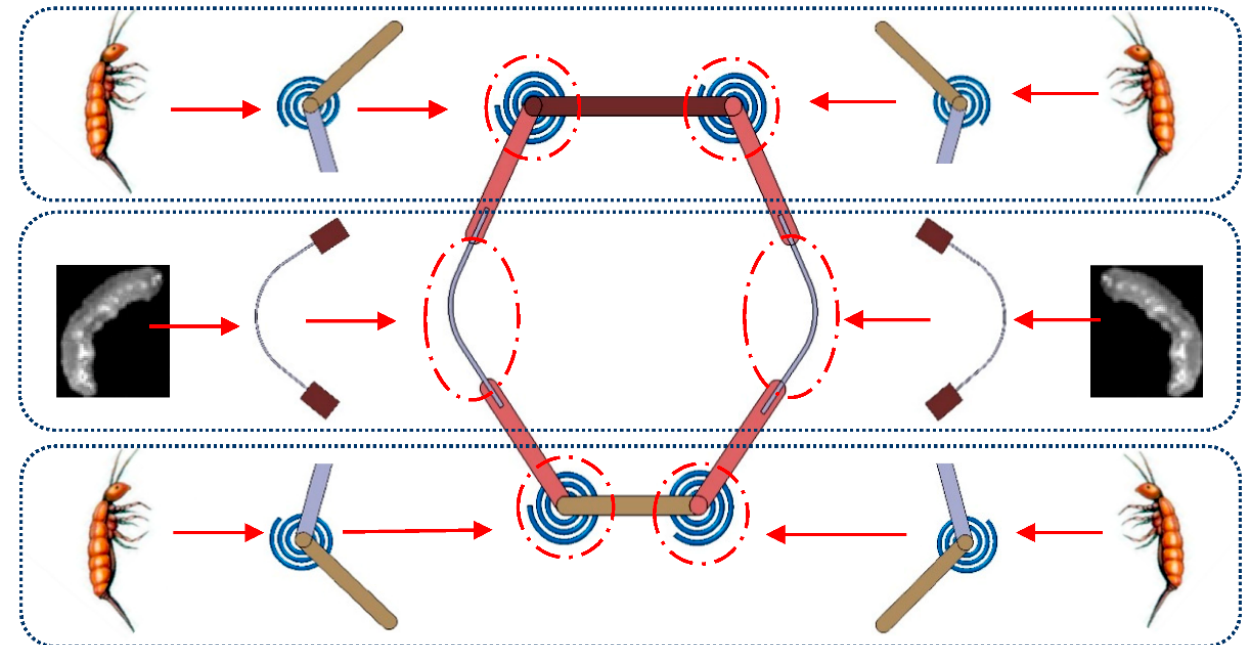
Figure 3. The quasi-six-bar jumping mechanism is composed of two bionic mechanisms.